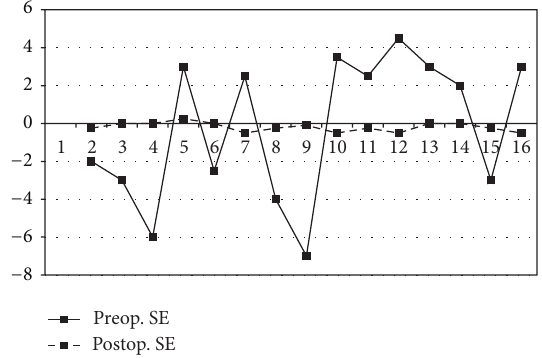
Figure 1: Pre- and postoperative vision in last visit.